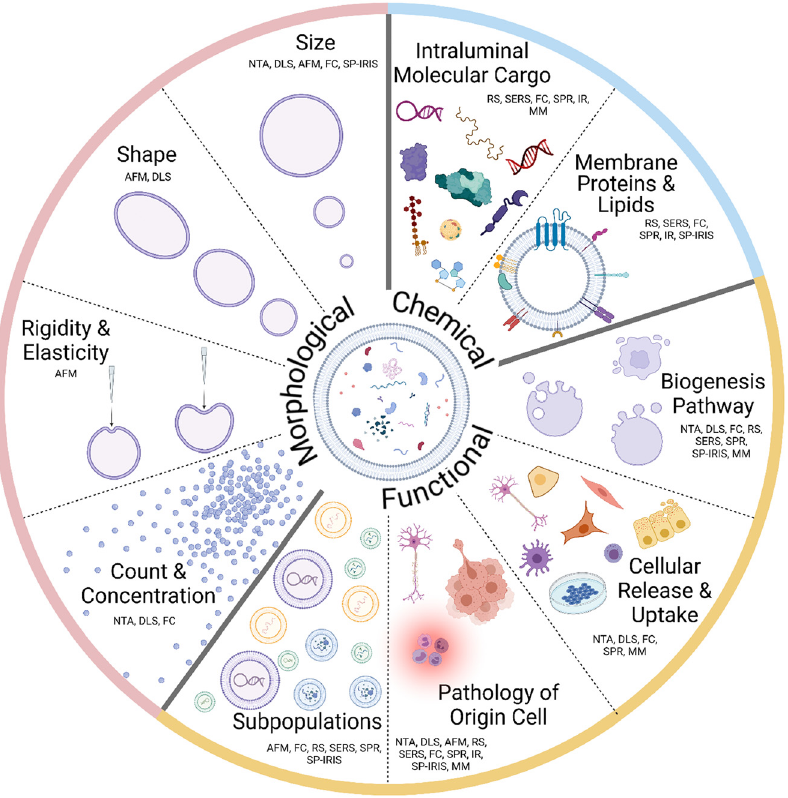
Figure1: Opticallabel-freecharacterizationmethodologiesforEVheterogeneitycharacterization.CategoriesofEVsheterogeneityaredivided into morphological, biochemical, and functional heterogeneity. Morphological heterogeneity category includes size, shape, rigidity, elas- ticity, count, and concentration. Size of individual EVs can be determined by NTA, DLS, AFM, FC, and SP-IRIS. The size distributions within a population of EVs, as well as the count and concentration of EVs can be determined with NTA, DLS, and FC. The shape of EVs can